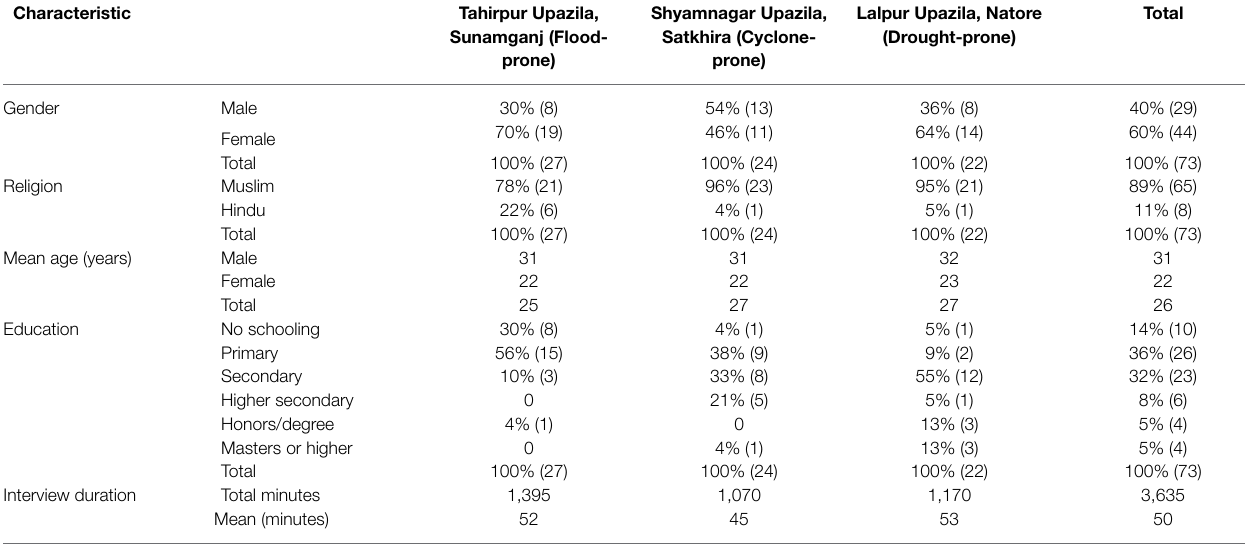
TABLE 1 | Socio-demographic characteristics of